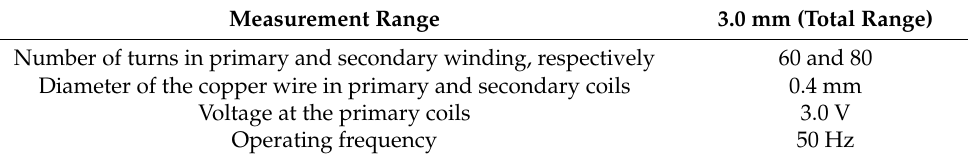
Figure 15. Details of the MEMS LVDT. Table 9. Details of miniature LVDT.